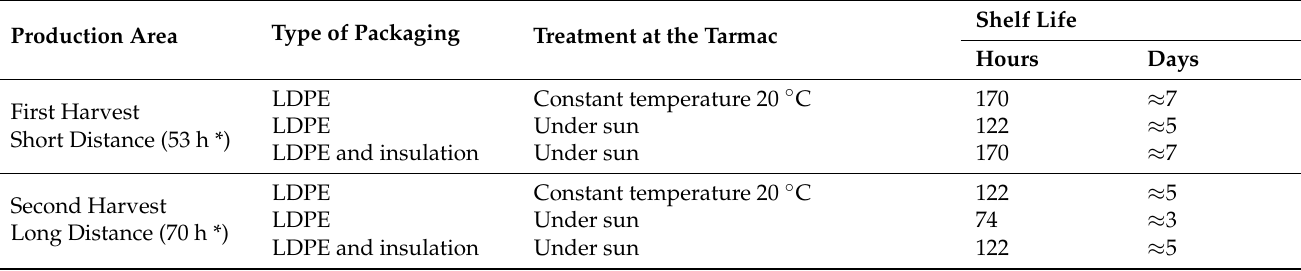
Table 3. Shelf life of mango fruits after simulated handling